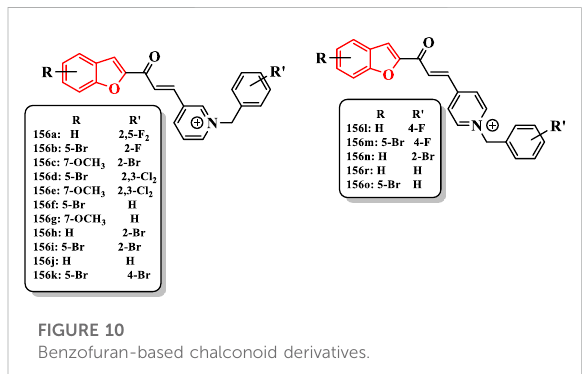
FIGURE 10 Benzofuran-based chalconoid